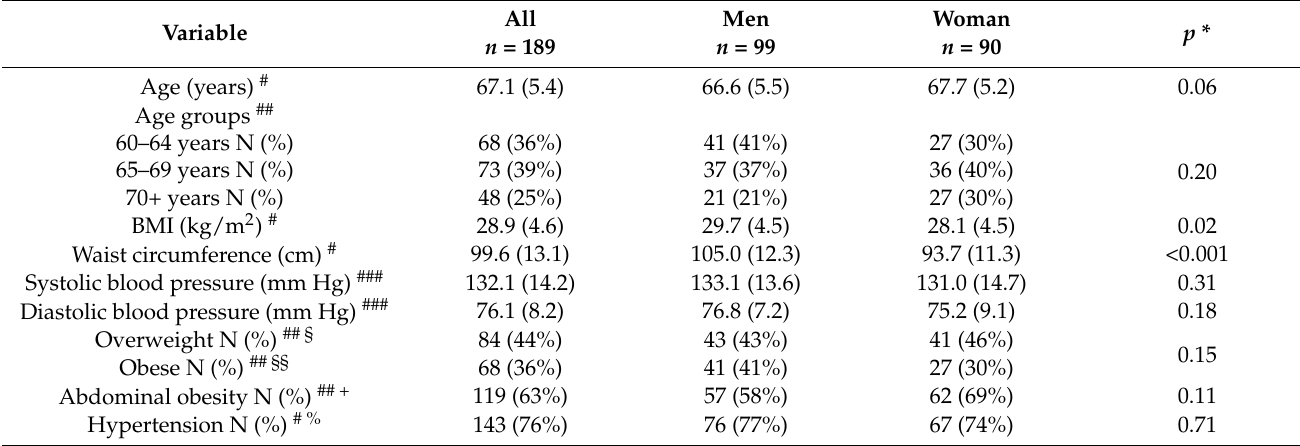
Table 1. Demographic and anthropometric characteristics of study participants, Biomarker2019 survey.